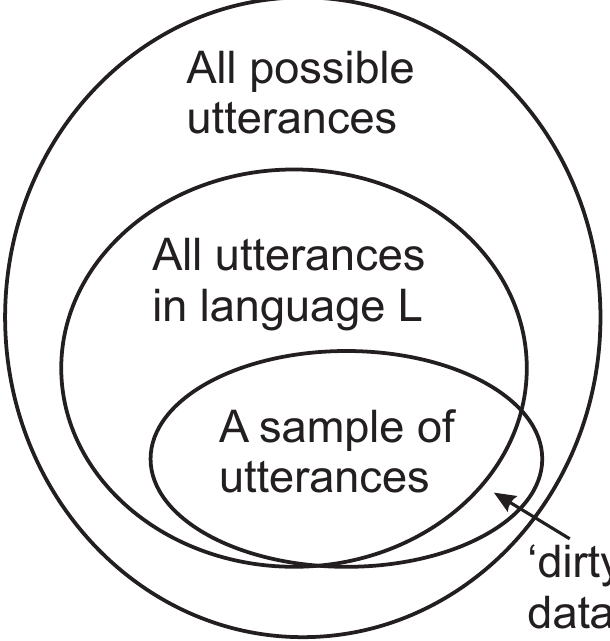
Figure 11. Categories of utterances involved in the learning of a first language, L . In ascending order size, they are: the finite sample of utterances from which a child learns; the (infinite) set of utterances in L ; and the (infinite) set of all possible utterances. Adapted from Figure 7.1 in [10], with